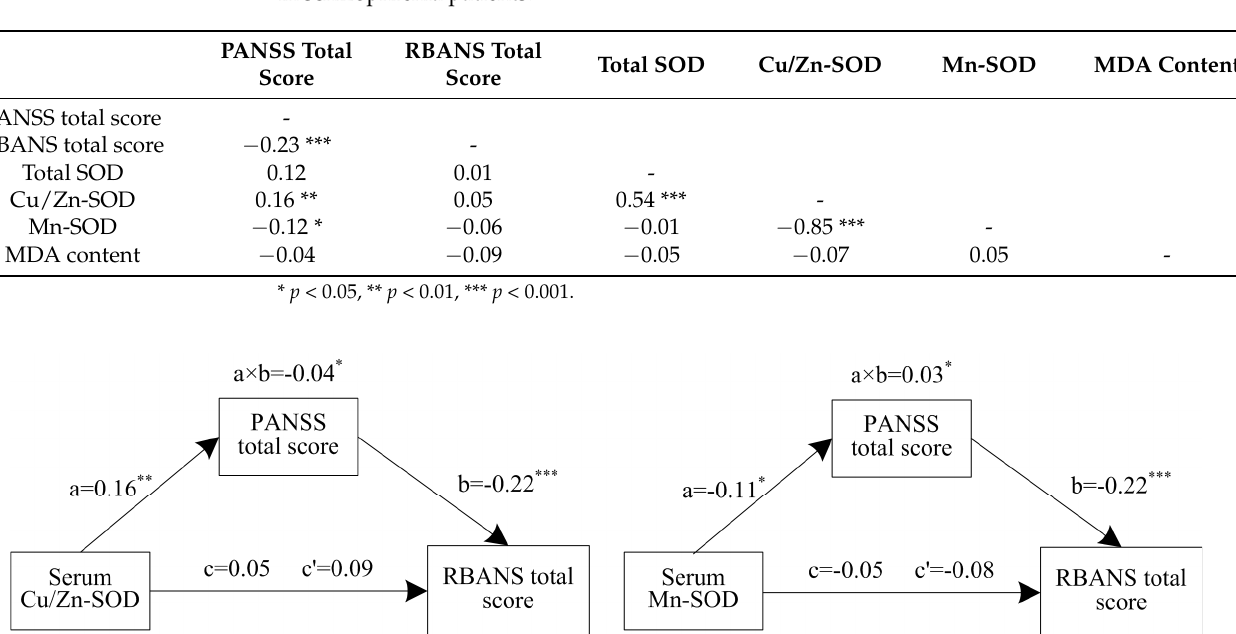
Table 3. Partial correlation among psychotic symptoms cognitive performance and oxidative stress in schizophrenia patients.